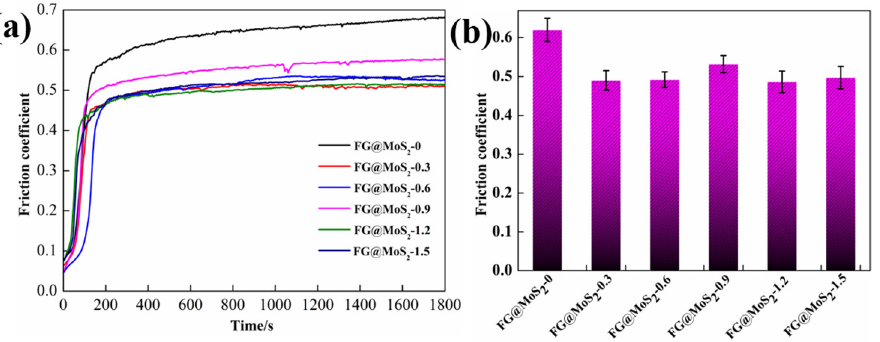
Figure 3. ( a ) Real-time friction curve and ( b ) average friction coefficient of CFRP containing different contents of FGr@MoS 2 hybrid.